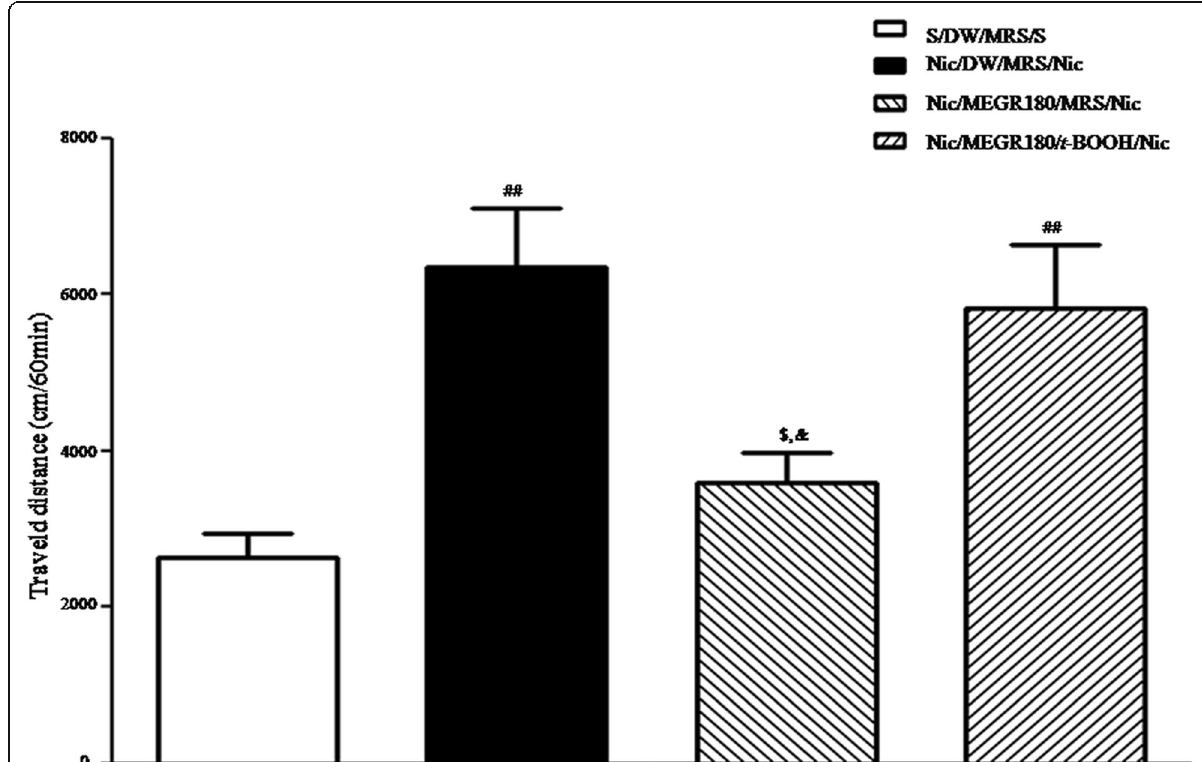
Fig. 5 Effects of intra-NaccSh infusion of t -BOOH on the anti-sensitization action of MEGR. Sixty minutes after the 4th MEGR, rats received bilateral infusions of t -BOOH into the NaccSh, were systemically challenged with nicotine, and then tested in the locomotor testing boxes for 60 min. All data are expressed as means ± SEM ( n =4 – 5). Nic: nicotine, S: saline, MRS: modified Ringers ’ solution, MEGR: methanol extract of G. radix , MEGR180: 180 mg/kg/day MEGR once a day for 4 consecutive days. ## P <0.01versus S/DW/MRS/S group; $ P <0.05 versus Nic/DW/MRS/Nic group; & P <0.05 versus Nic/MEGR60/ t -BooH/Nic group (one-way ANOVA followed by Newman-Keuls post-hoc